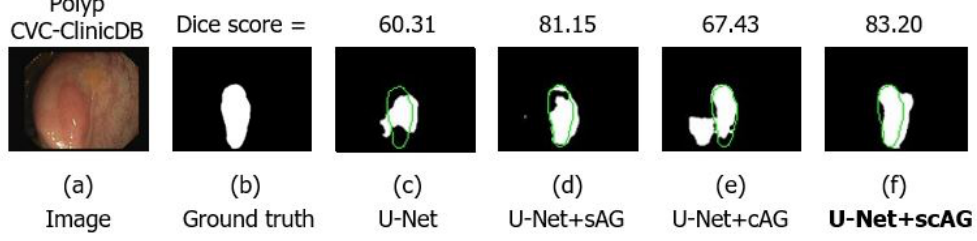
Figure 7. Example results by using separate attention gate.